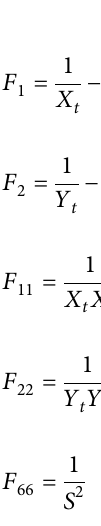
Figure 1: Static aeroelastic coupling